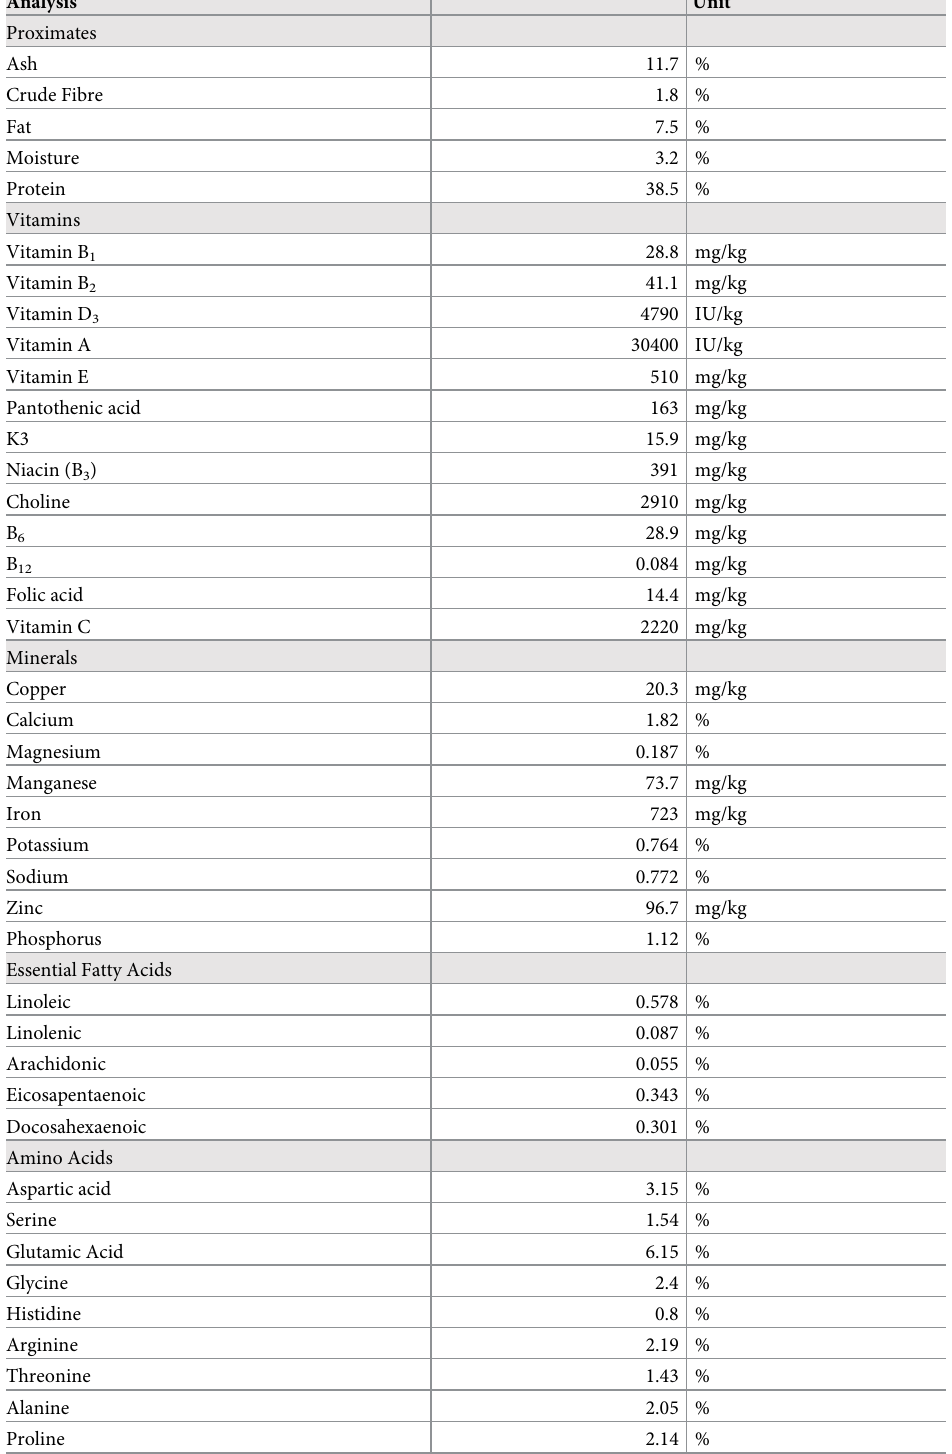
Table 1. Nutritional analysis of tadpole food (% dry matter basis) batch prepared by the Waltham Petcare Science